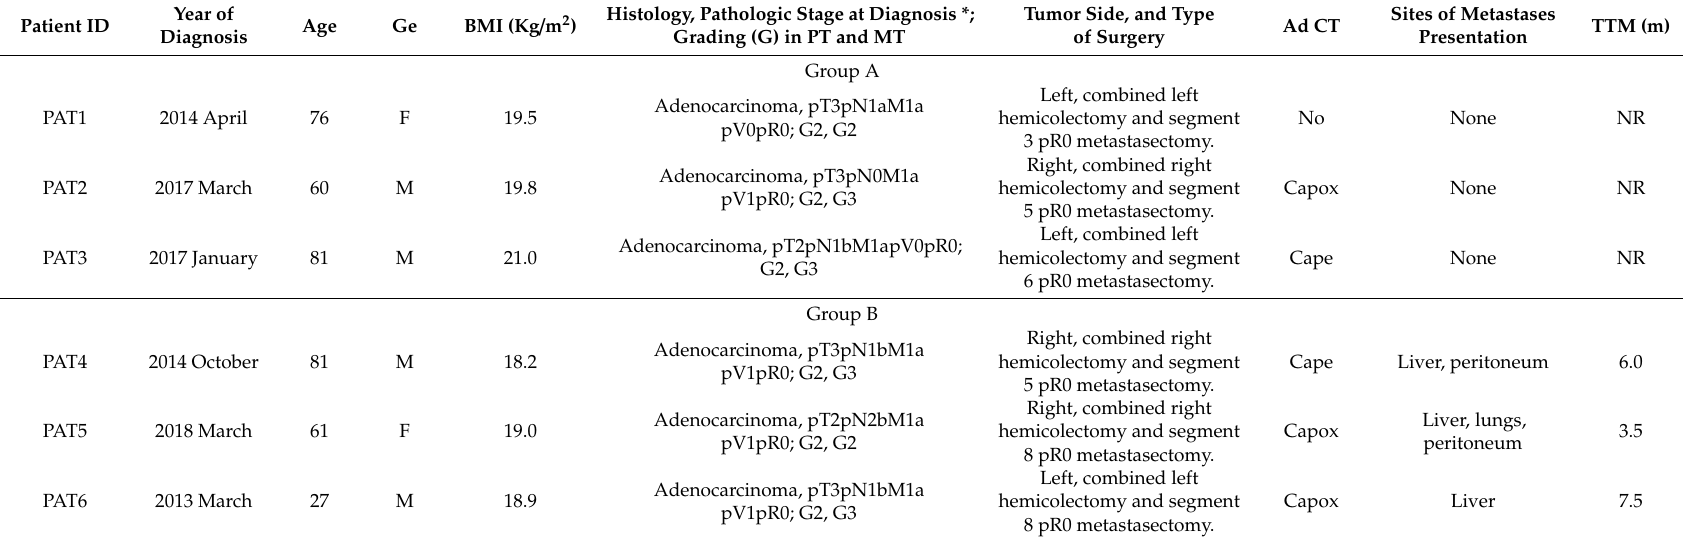
Table 1. Clinico-pathological characteristics of the enrolled patients (I).